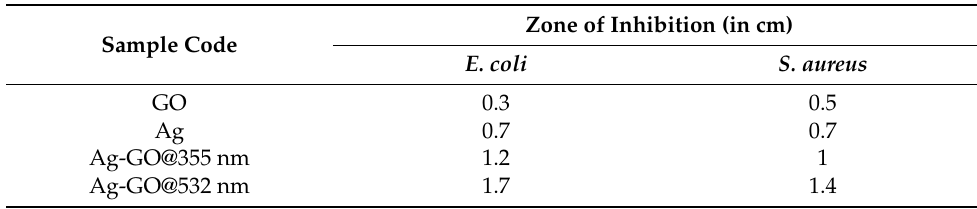
Table 1. Inhibition zone diameters of E. coli and S. aureus bacteria treated with Ag-GO@355 nm and Ag-GO@532 nm samples.